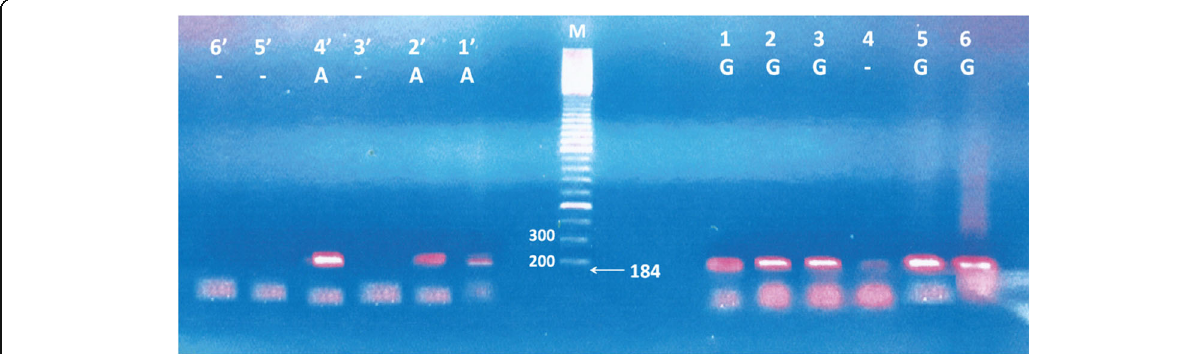
Fig. 1 TNF- α − 308 G/A polymorphism in CL patients. Lane M indicates for DNA ladder 100 bp, lanes 1 and 1 ’ represent GA genotype for sample 1, lanes 2 and 2` represent GA for sample 2, lanes 3 and 3` represent GG genotype for sample 3, lanes 4 and 4` represent AA genotype for sample 4, lanes 5 and 5` represent GG genotype for sample 5 and lanes 6 and 6` represent GG genotype for sample 6. All TNF- α − 308 G/A genotype polymorphism detected at the same size (184 bp) by the amplification refractory mutation system